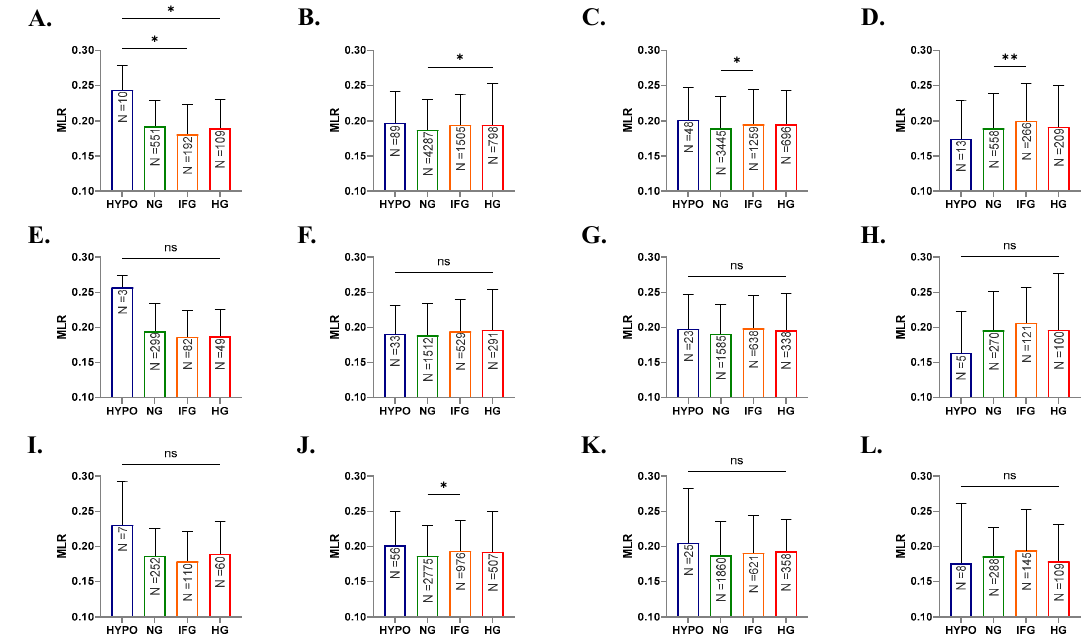
Figure 3. Effect of age, sex, and FBG on MLR. Medians + IQR of MLR in young, young adults, adults, and elderlies of both genders ( A – D ), of males ( E – H ), and of females ( I – L ). ns indicates not significant, while * p < 0.05 and ** p < 0.01.